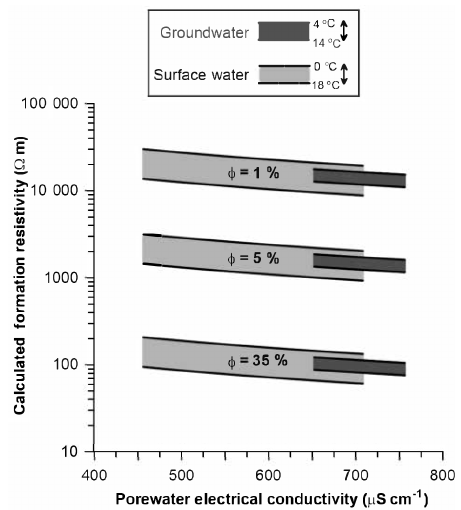
Figure 7. Calculated formation resistivity based on Eq. (1) and mea- sured variations in surface water and groundwater electrical conduc- tivity, including effects of temperature based on Eq. (2). A cemen- tation factor of 1.4 was used to represent the fractured dolostone bedrock. Measured water conductivity and temperature were ob- tained from CTD-Diver ™ sensors deployed in RSG4 (surface wa- ter) and SCV6 (groundwater at a depth of 8mb.g.s.), and the con- tinuous RBR ™ temperature profiles shown in Fig. 5b. These data show the potential range in formation resistivity based on the mea- sured range in specific conductance, along with the potential impact of temperature for three different porosity values. Porosities of 1 and 5% correspond to the range measured in the core, while a value of 35% would be representative of a rubble